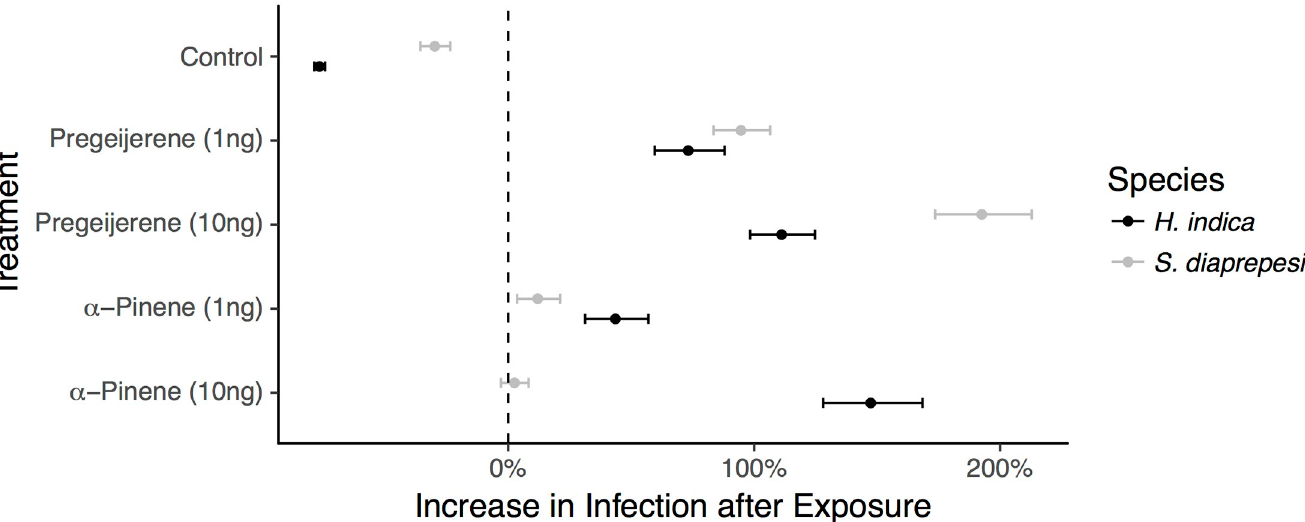
Fig 3. Exposure increases infection. Increase in numbers of experienced infective juveniles previously exposed to the treatment volatile recovered from G. mellonella larvae paired with treatment volatiles. (i.e. The entomopathogenic nematode infective juveniles infecting G. mellonella larvae paired with pregeijerene were previously exposed to pregeijerene.) Increase is calculated relative to numbers of inexperienced (non-exposed) infective juveniles recovered from G. mellonella larvae paired with treatment volatiles. Controls are nematode only controls; host insects were not treated with volatiles. Exposed cohorts in controls had experience with pregeijerene. Points and error bars denote means and 95% confidence intervals respectively.